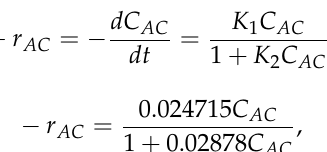
Figure 7. Heterogeneous LH catalysis model applied to the degradation of acetaminophen in an RFR reactor. The solid line represents the model and the points represent experimental data (catalyst mass = 1 gr/L, rotational speed = 54 rpm, radiation of λ = 254 nm, number of lamps = 6, reaction volume= 12 L, maximum reaction time = 50 h) Acetaminophen has been one of the most studied pharmaceuticals under advanced oxidation processes recently [28]. Hollow core-shell mesoporous TiO 2 microspheres were synthesized by a template-free solvothermal route for efficient photocatalytic degradation of acetaminophen data revealed a micrometer-sized mesoporous anatase TiO 2 hollow sphere with large surface area and efficient light harvesting. The conversion fraction of the pharmaceutical increased from 88% over commercial Degussa P25 TiO 2 to 94%. The use of doped materials has also been reported [27]. This